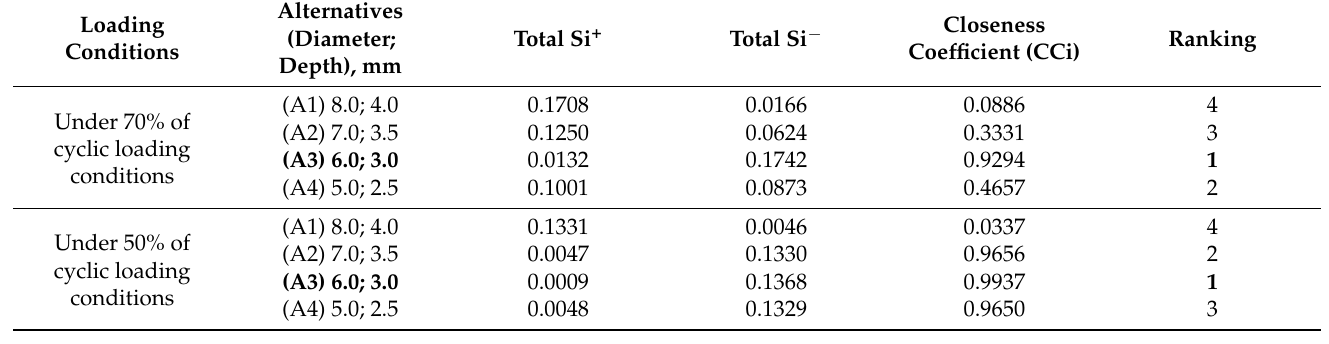
Table 15. Summation of FPIS and FNIS through all the main alternatives to determine the dimple core configuration ranking, based on the Closeness Coefficient analysis.